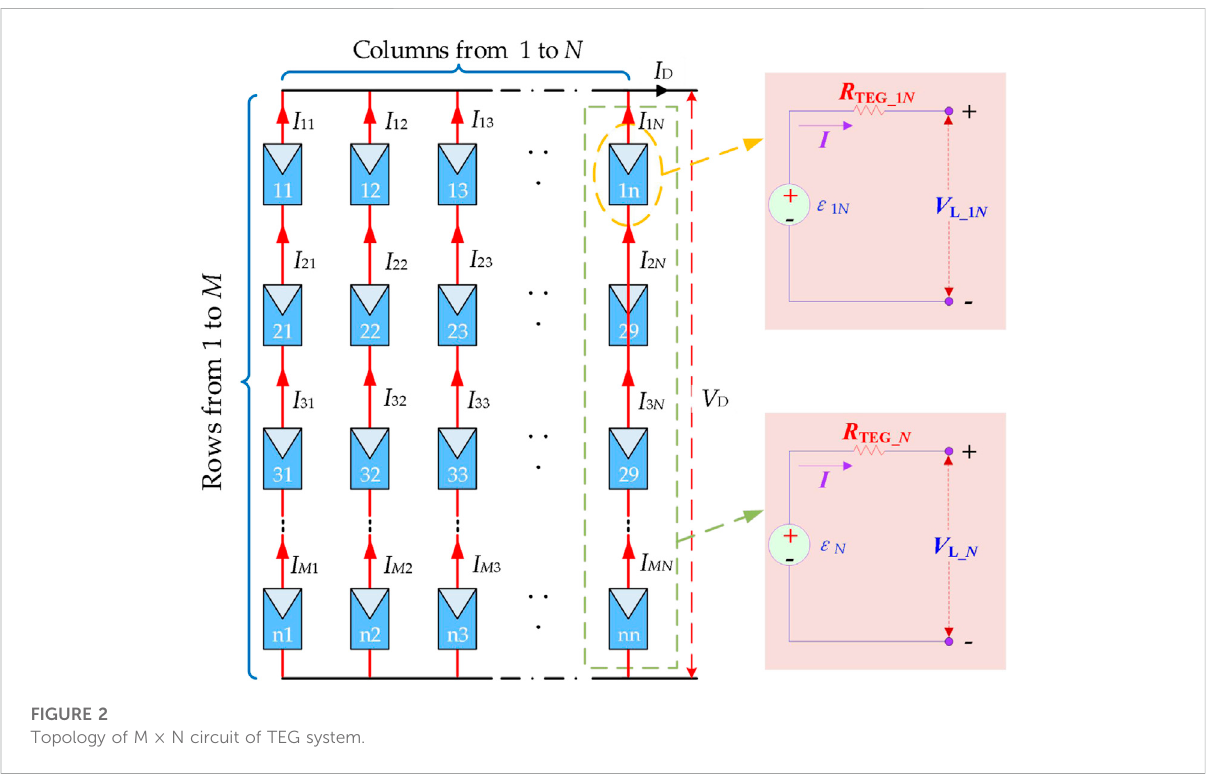
FIGURE 2 Topology of M × N circuit of TEG